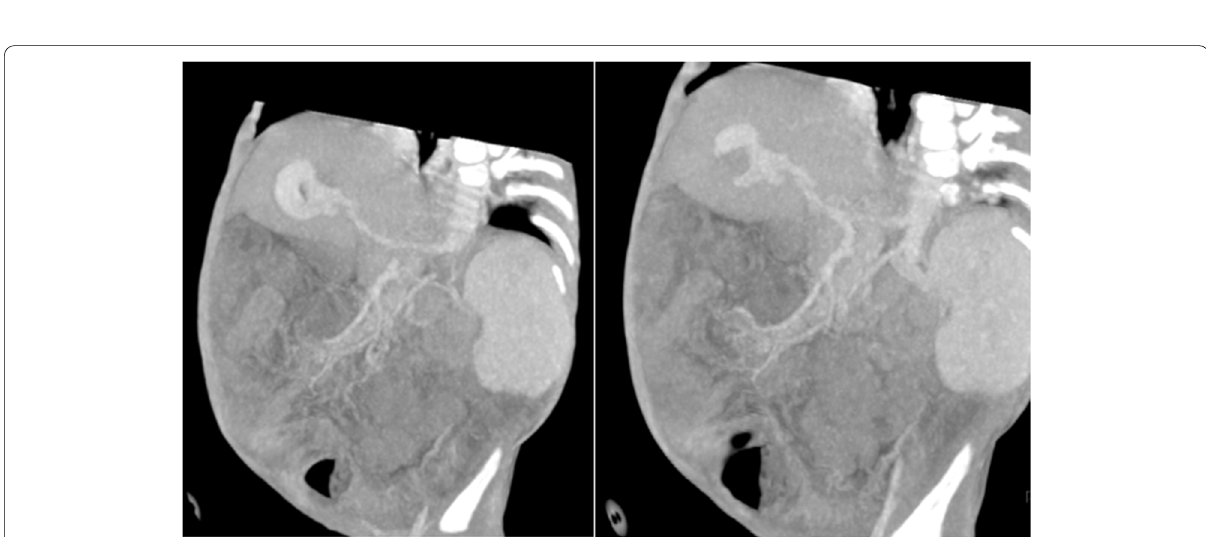
Fig. 2 Coronal Maximum Intensity Projection images showing the high flow fistula with arterial supply from the left hepatic artery (left) and venous drainage into the left portal vein